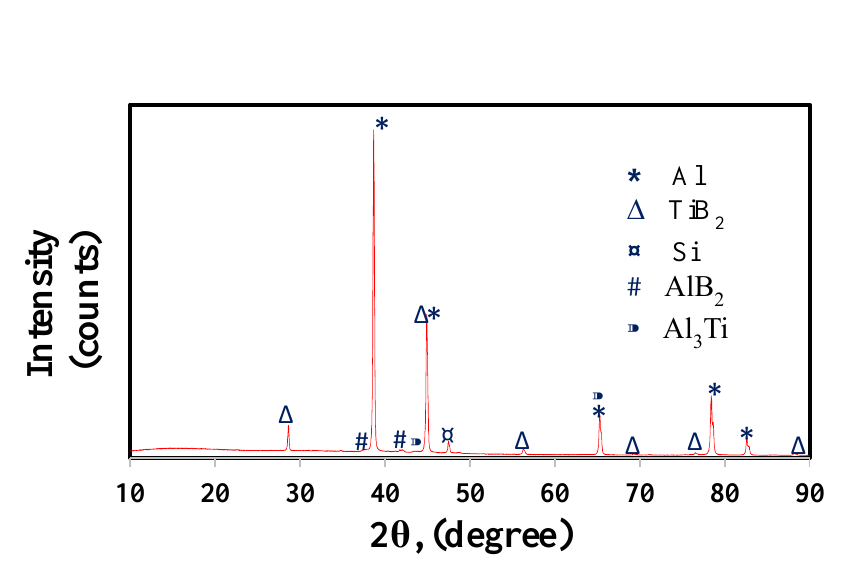
Fig. 4. XRD plot of Al-Si-Mg/TiB 2 in situ composites fabricated by salt synthesis route. Theoretically, as the reaction temperature rises, the decrease in Gibbs free energy of Al 3 Ti decreases, indicating that Al 3 Ti is unstable [18]. Consequently, TiB 2 increased, Al 3 Ti decreased, and more Ti was converted to the TiB 2 phase